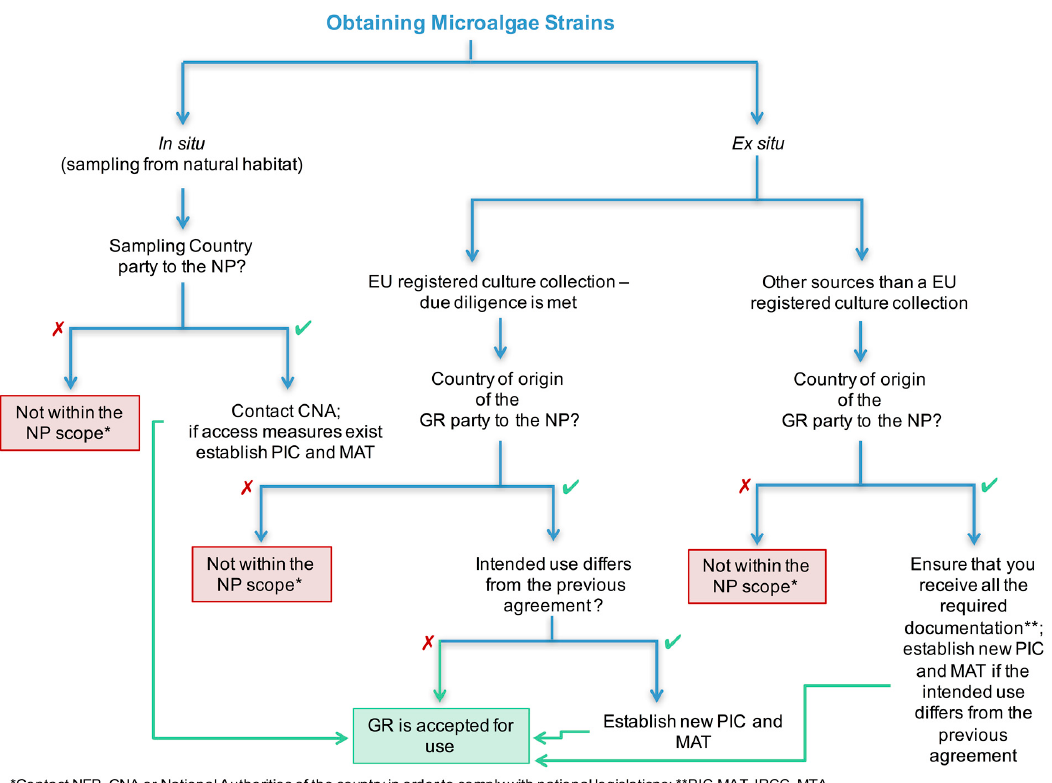
Figure 1. Nagoya Protocol (NP) decision tree for accessing genetic resources (GR) in accordance with the scope of the Access and Benefit-Sharing (ABS) Regulation.